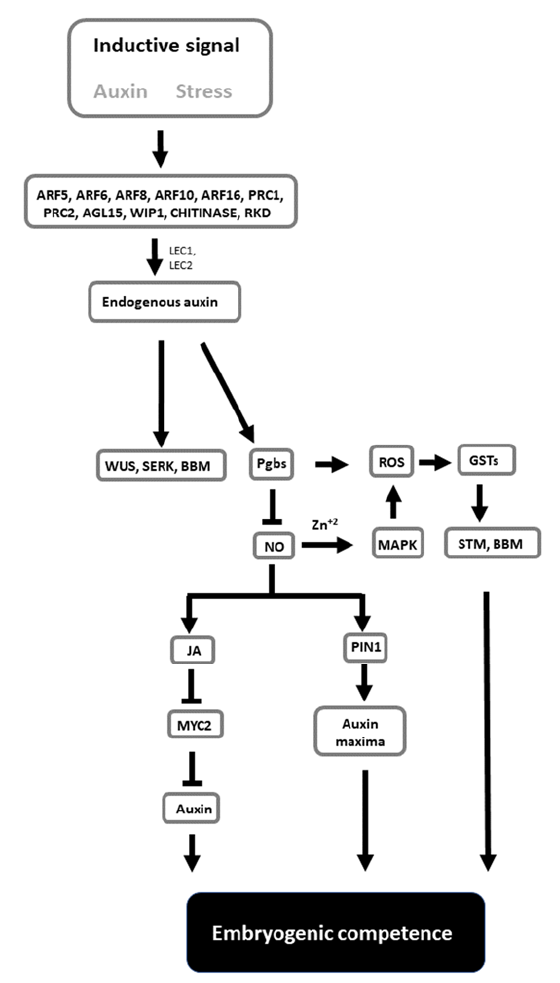
Figure 1. Tentative model highlighting the relevant components contributing to the acquisition of embryogenic competence. Inductive signals trigger responses increasing the level of endogenous auxin, which promotes the expression of SE marker genes such as WUS, SERK and BBM. Auxin also induces Pgbs, which, through suppression of NO, initiate a cascade of events mediated by JA and MYC2 and culminating with changes in auxin level and localization. The process also requires oxidative responses. Genes indicated in the figure are described in more detail in the text. Author Contributions: Conceptualization, M.E.; writing, M.E. and C.S. All authors have read and agreed to the published version of the manuscript.